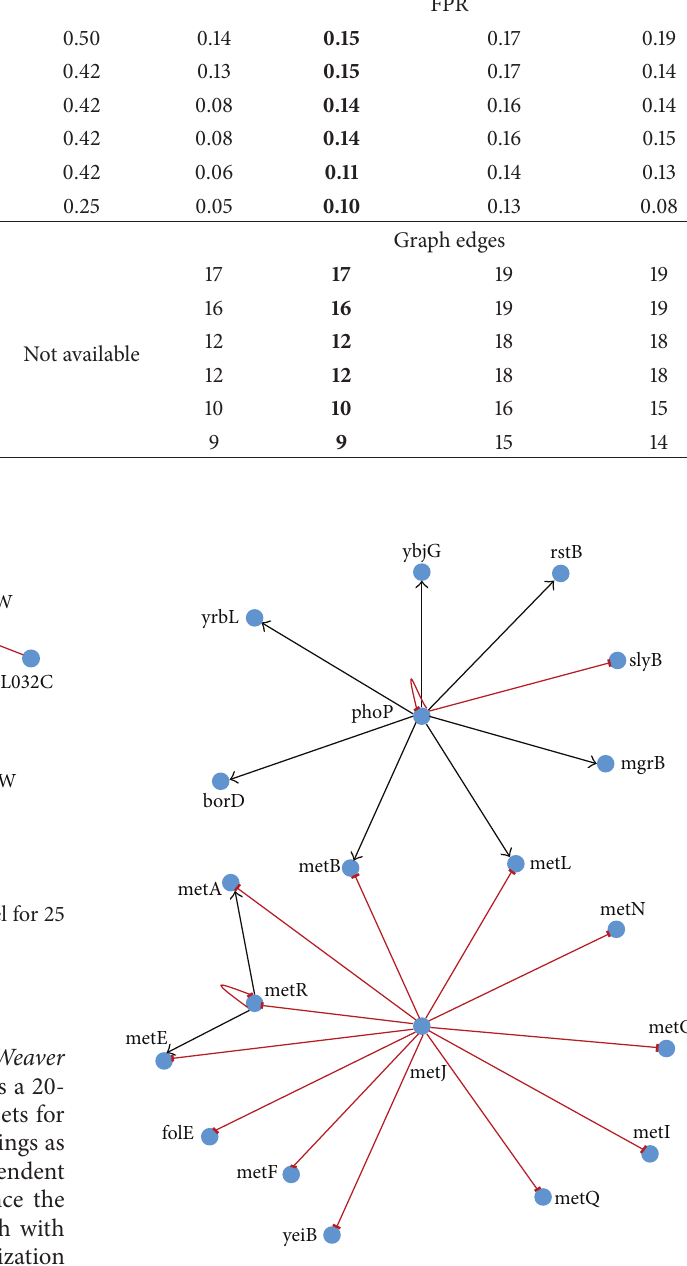
Figure 9: Original 20-gene network extracted from the genome of E. coli stored in